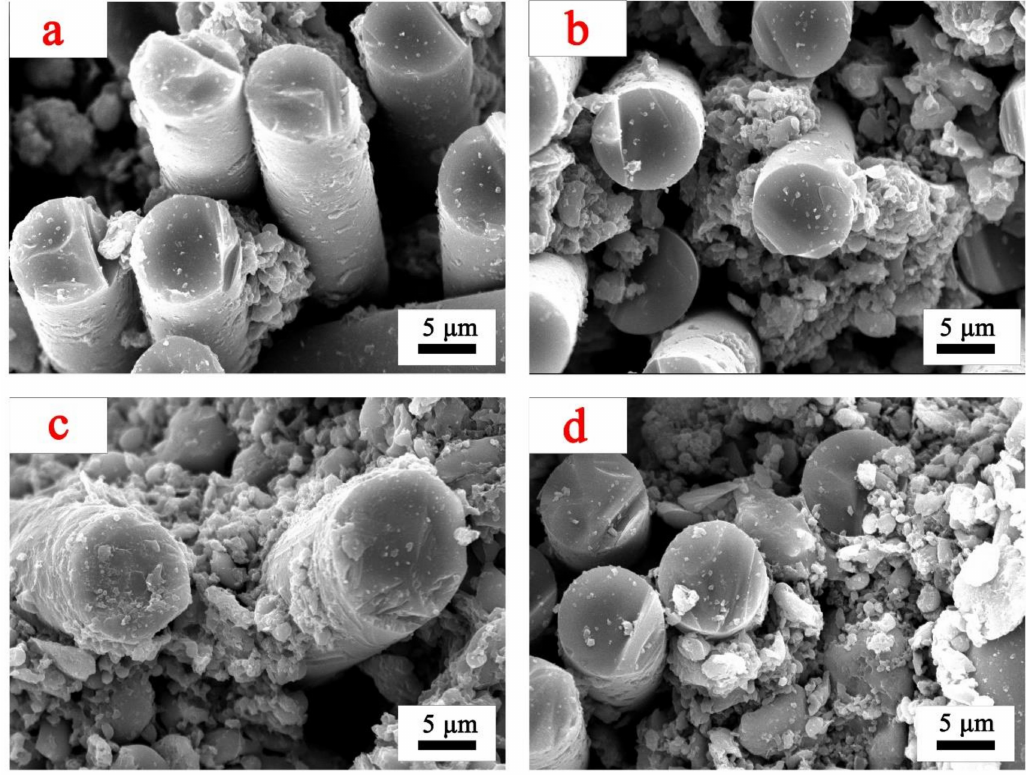
Figure 5. Micromorphology of samples treated at 1000 ◦ C: ( a ) micromorphology of sample R1, ( b ) micromorphology of sample R2, ( c ) micromorphology of sample R3, ( d ) micromorphology of sample